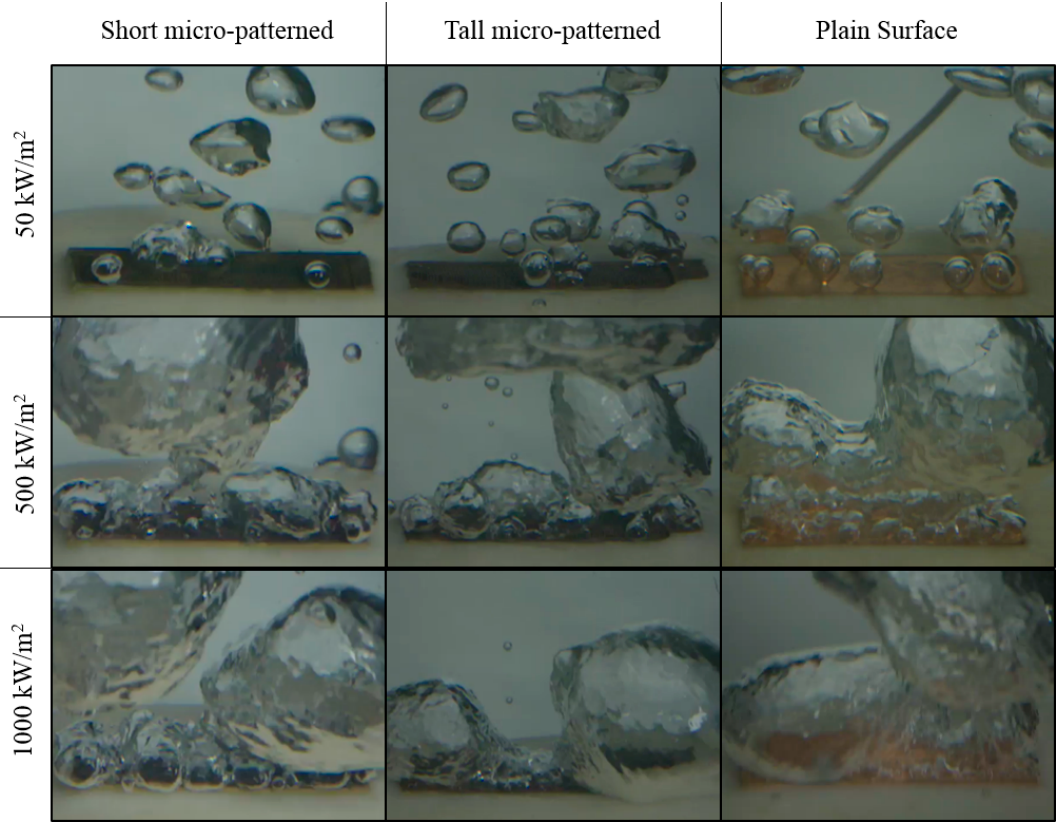
Figure 9. Captured images during the pool-boiling tests.